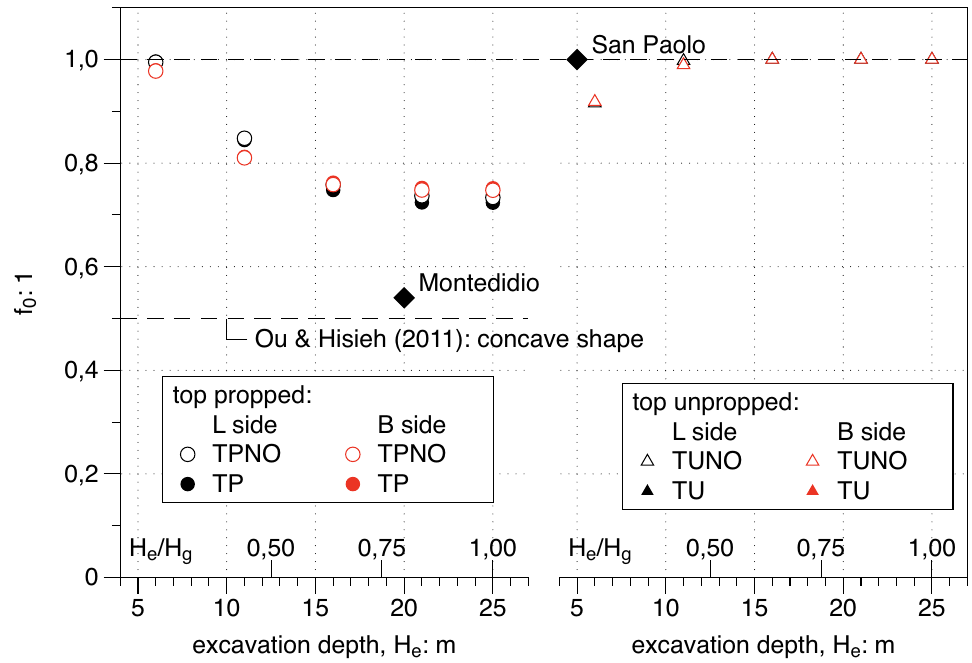
Figure 13. Dependency on the excavation depth H e of the value f 0 of the transversal settlement function f at the edge of the excavation.